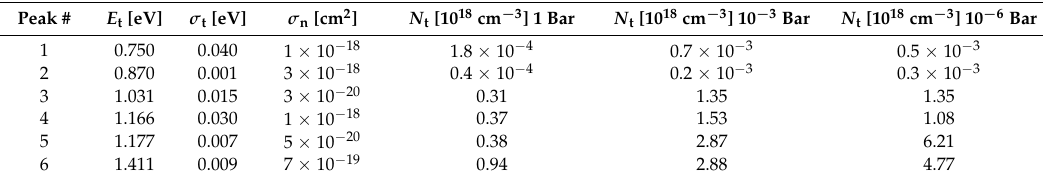
Table 2. Best fit trap parameters of the TSC measured after storage in different pressures of He atmosphere at room temperature during illumination with a Xe